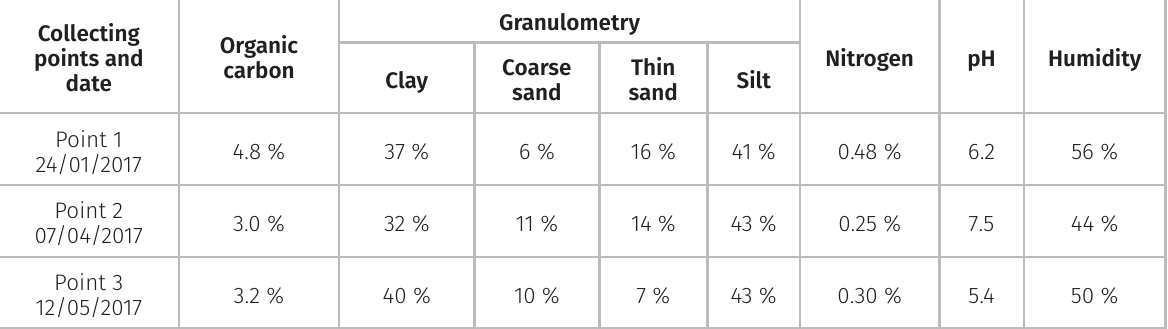
Table I. Result of the physicochemical parameters analyzed in the three sediment samples collected. Collecting points